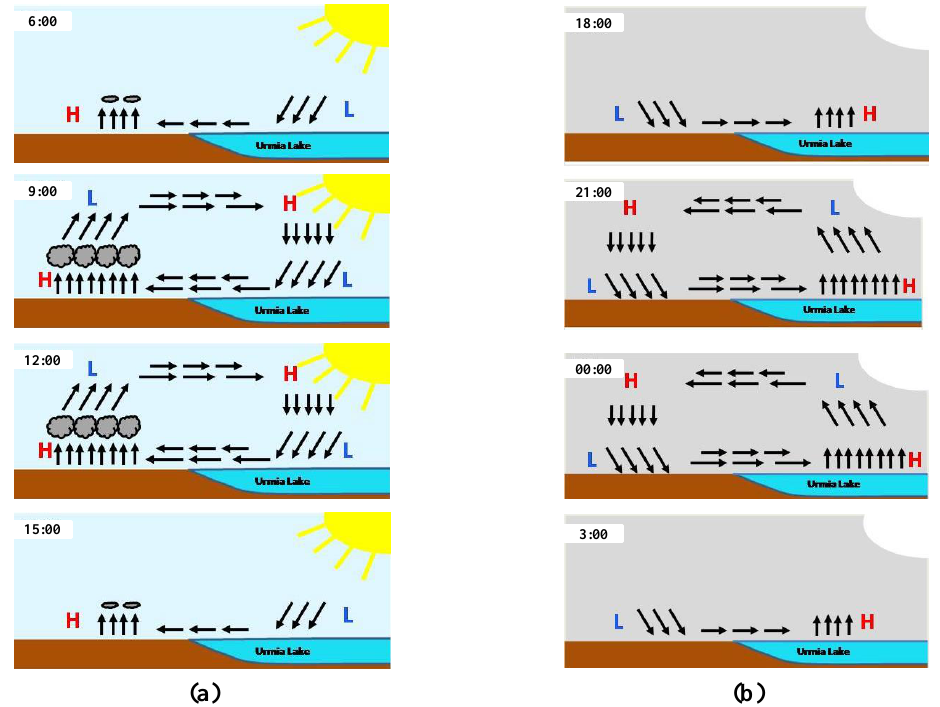
Figure 2. Schematic diagrams showing formation of ( a ) lake breeze during the day and ( b ) land breeze during the night, at the edge of Lake Urmia.